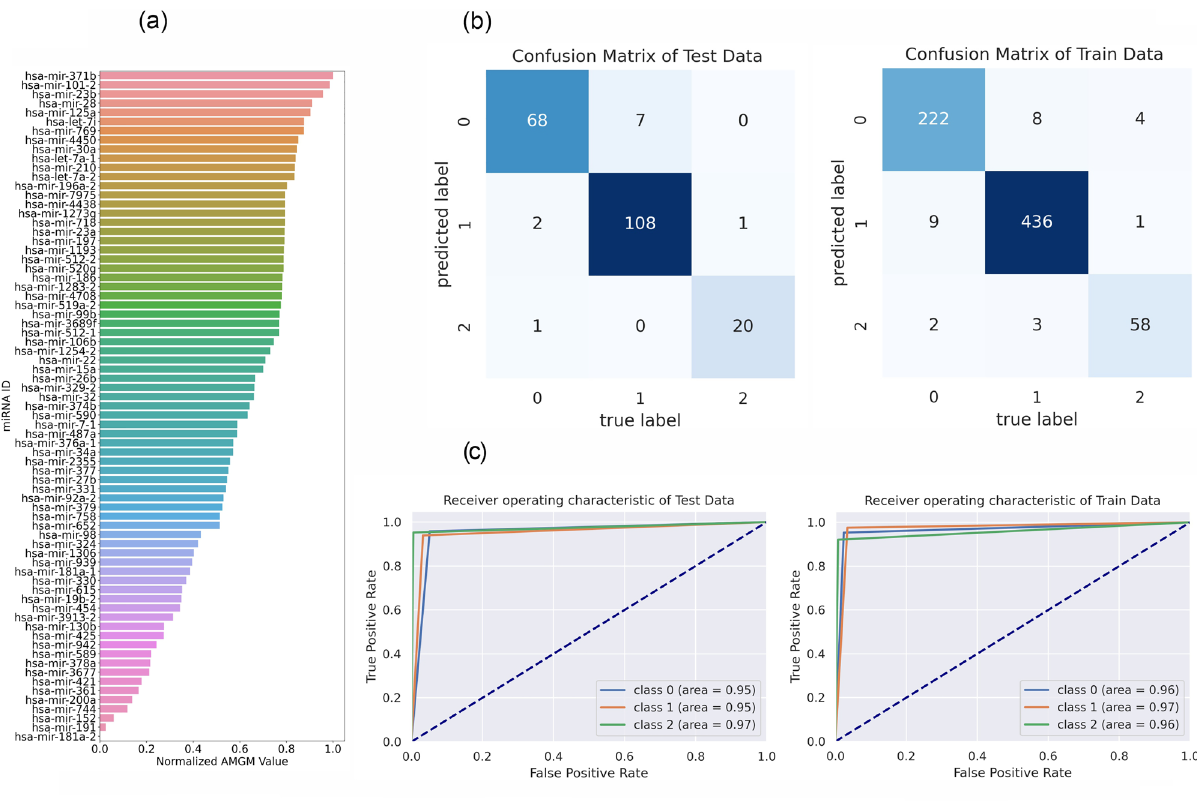
Figure 2. The performance of feature selection and classification steps in the miRNA data. ( a ) Bar plot of candidate miRNAs (73) based on normalized AMGM values. ( b ) Confusion matrix of training and test data, in which 0, 1, and 2 are pointed to KIRP, KIRC, and KICH groups, respectively. ( c ) Receiver Operating Characteristic (ROC) curve of training and test data. The Area under the Curve of Receiver Operating Characteristic (AUC-ROC) is reported for each